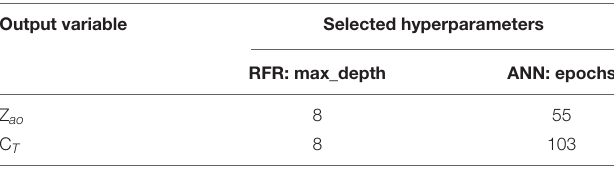
TABLE 1 | List of the selected hyperparameters for the predictive